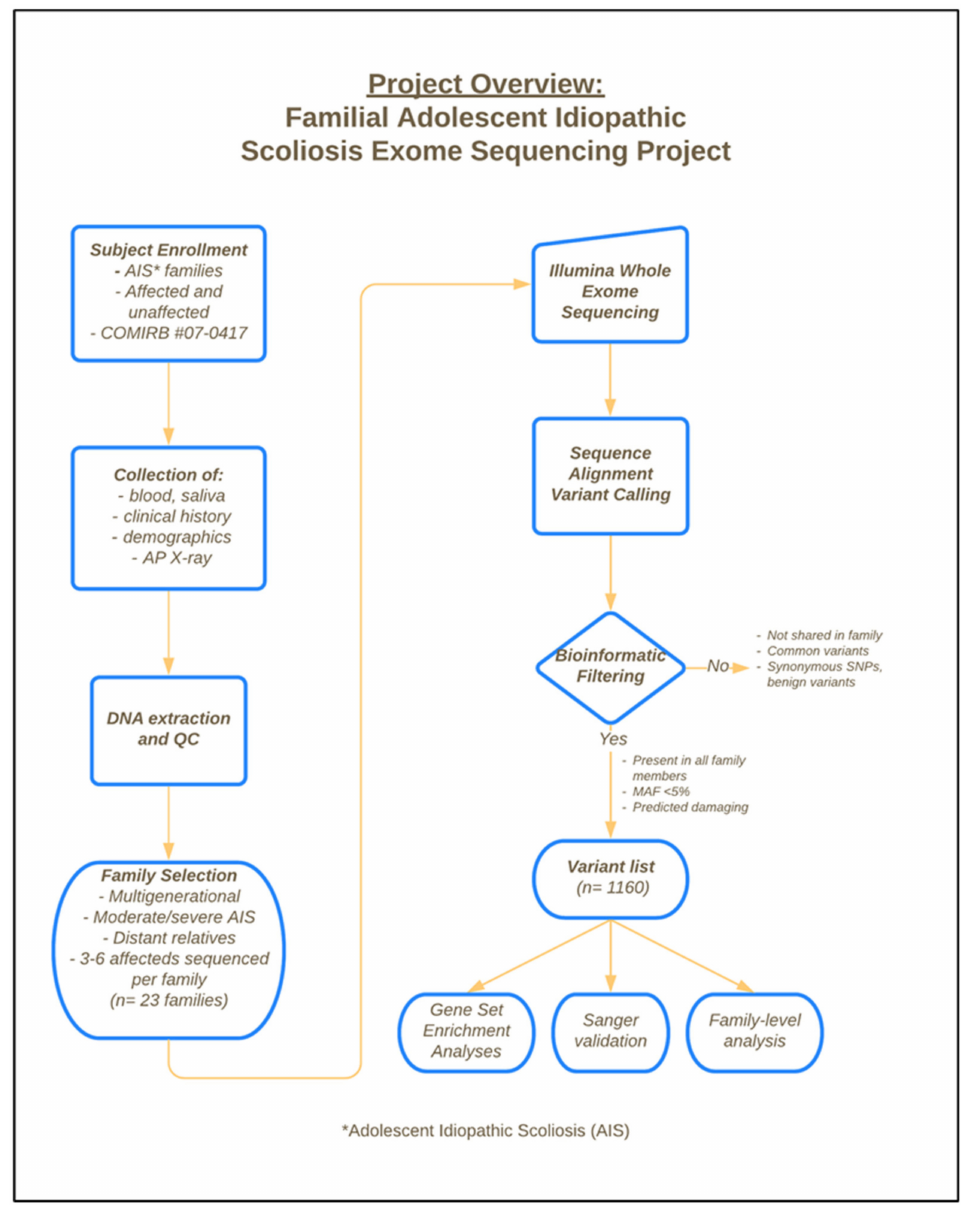
Figure 1. Project overview of subject enrollment, sample collection and extraction, exome sequencing, and bioinformatic filtering